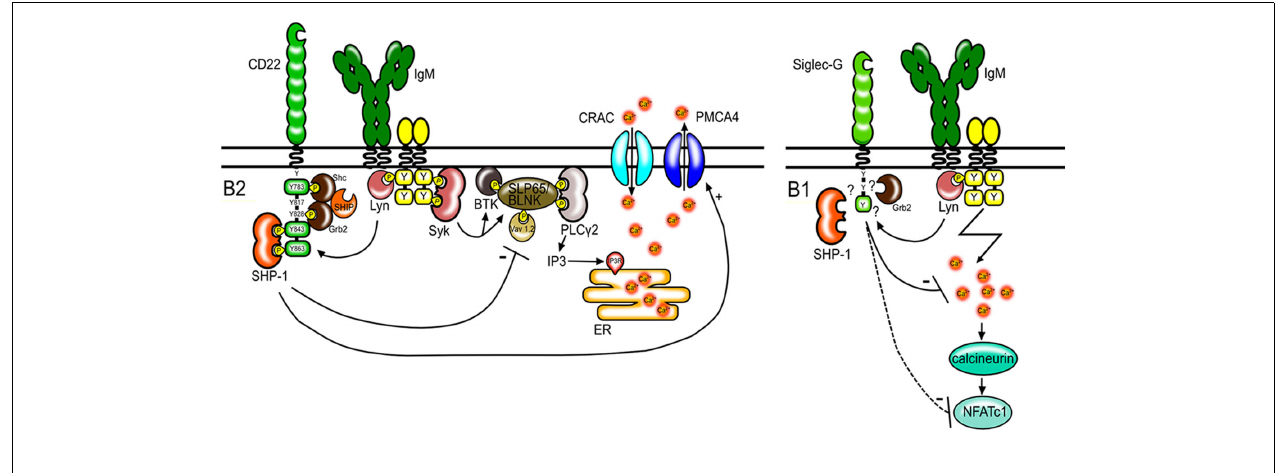
depletion of calcium stores from the endoplasmic reticulum (ER) and promotes calcium efflux through PMCA4. Shc and Grb2 bind to the indicated tyrosines and form a complex with SHIP. However the role of these molecules in CD22 transmitted inhibitory signals is not known. Siglec-G also has one ITIM motif (green box) and dampens the calcium signal on B1 cells thereby possibly influencing the activity and expression levels of the transcription factor